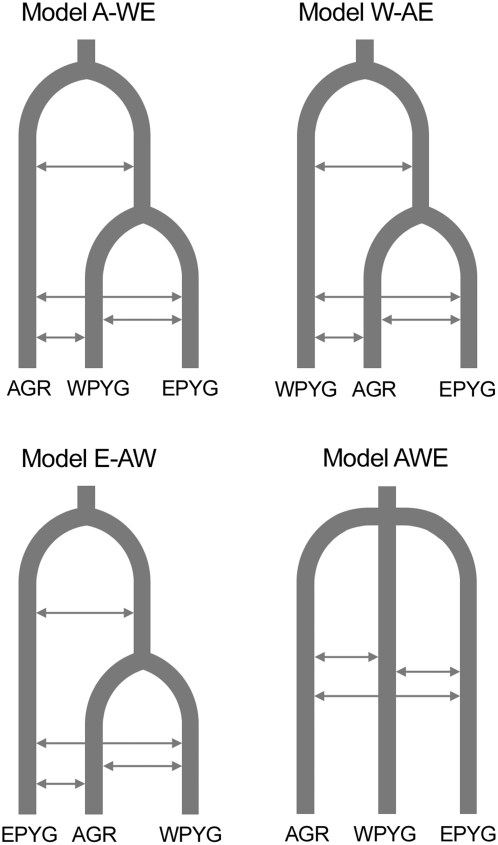
Four possible models explaining the branching history of African farmers, Western Pygmies, and Eastern Pygmies.Arrows indicate symmetric gene flow.